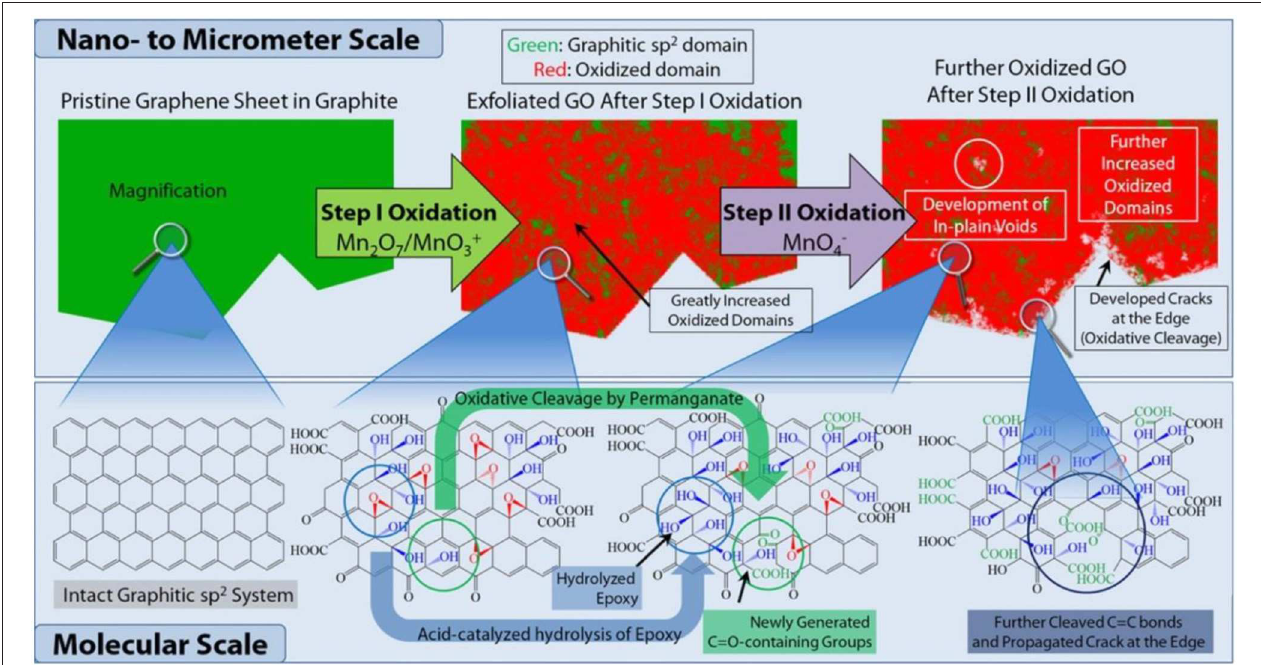
FIGURE 1 | Proposed reaction pathway for the aggressive oxidation of graphite in concentrated H 2 SO 4 and KMnO 4 to produce graphite oxide (modified Hummers reaction). Reproduced from Kang et al.